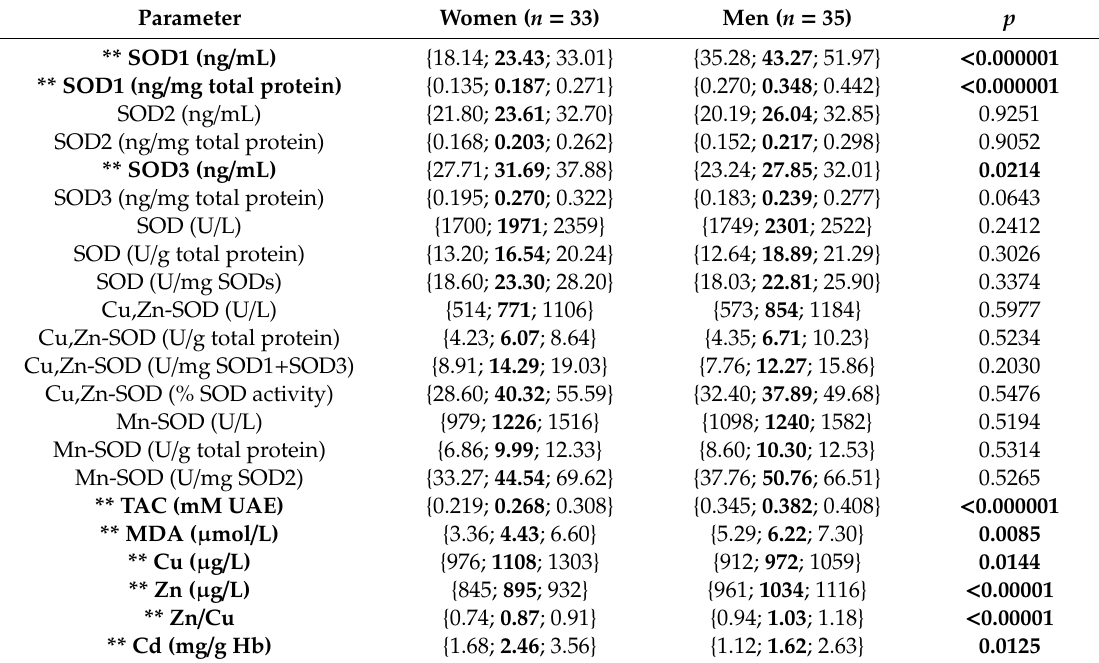
Table 1. Values of selected pro- and antioxidative parameters, and concentration of selected metals, in context of intersexual variability, in individuals not exposed to cigarette